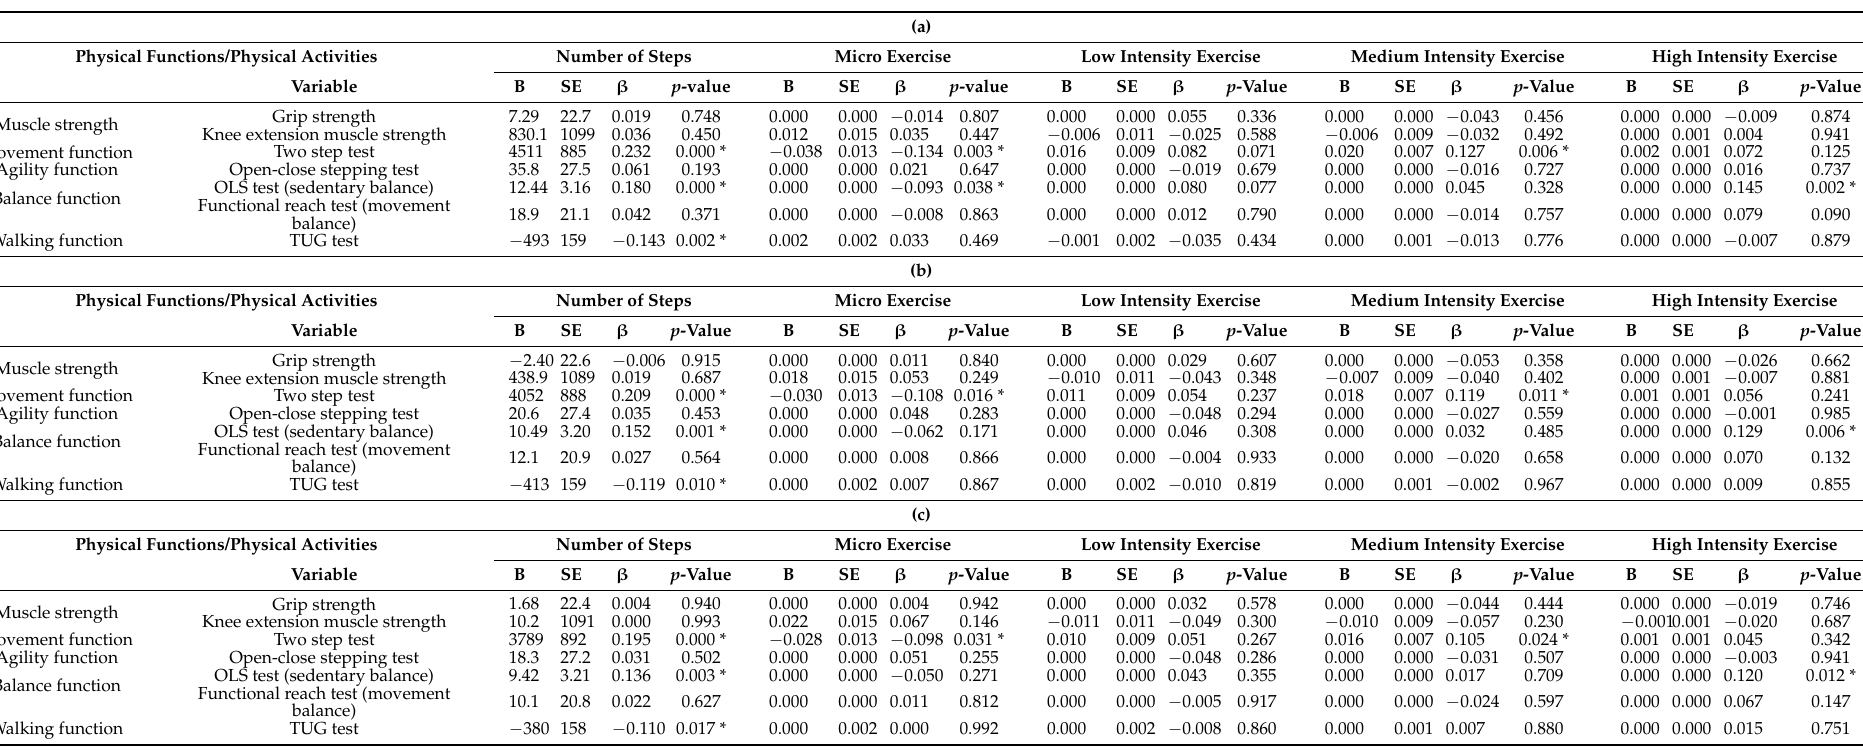
Table 3. ( a ) Results from multiple linear regression models adjusted for sex examining the association of physical activities with physical functions 1 . ( b ) Results from multiple linear regression models adjusted for sex and age examining the association of physical activities with physical functions 2 . ( c ) Results from multiple linear regression models adjusted for sex, age and body mass index examining the association of physical activities with physical functions 3